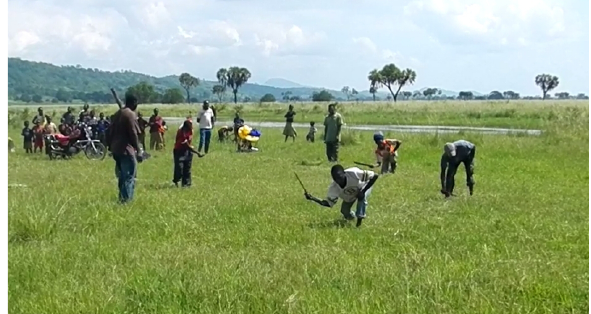
Figure 2. Preparation of an runway for SUSI 62 in the wetland. Like shown on the photo, it is possible to create a suitable runway quite